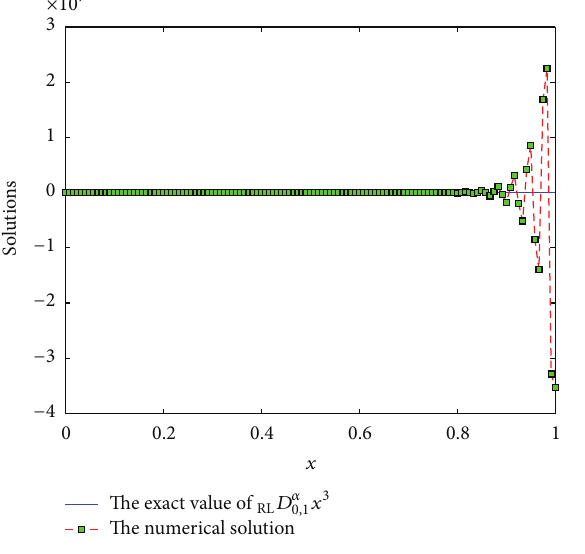
𝑥 3 and numerical solution of 𝐷 𝛼 0,1 RL